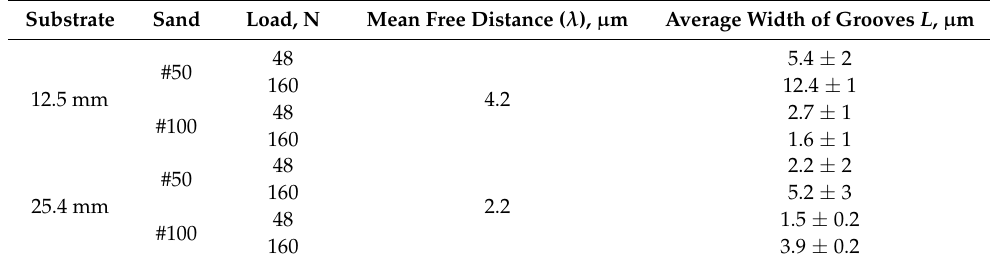
Table 8. Average width L of